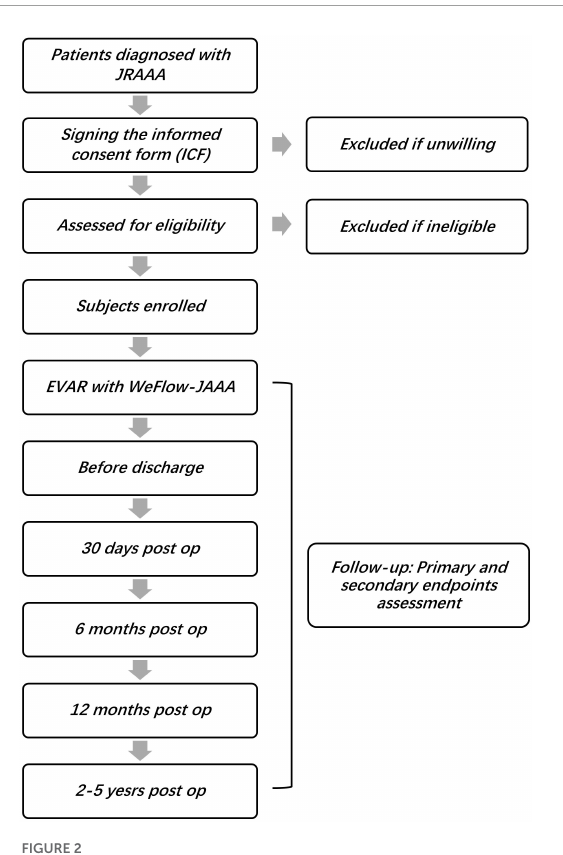
FIGURE2 The study flow chart. (JRAAA, juxtarenal abdominal aortic aneurysm; EVAR, endovascular aortic repair; op, operation).